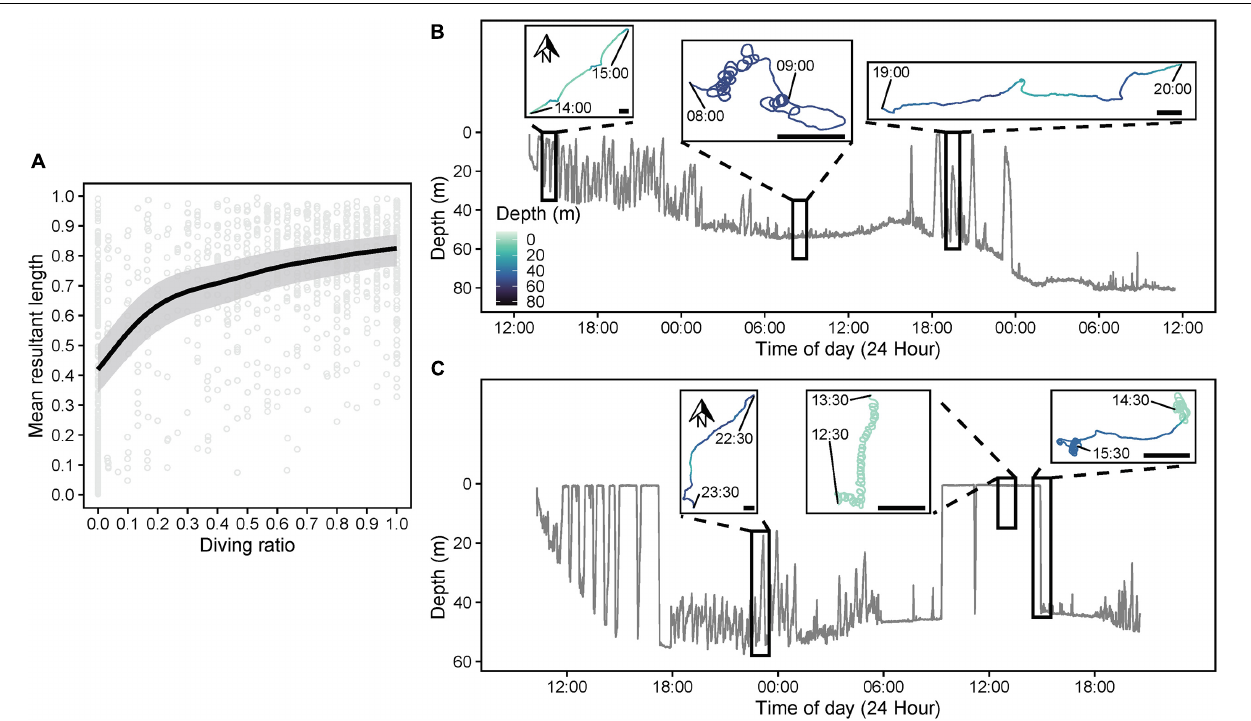
FIGURE 9 | (A) Predicted relationship (gray shading = 95% confidence intervals) between diving ratio (DR, proportion of time spent diving/in states 1 or 2) and mean resultant length ( R , 1 = low heading variance, 0 = high heading variance) from a beta generalized additive mixed model. DR and R were computed over 15 min windows for each shark. Dive profiles and corresponding pseudo-track sections over relevant windowed periods (black rectangles) for sharks (B) s291w and (C) s330w indicating representative examples of linear swimming during intensive diving periods and tortuous activity, including circling behavior, during level phases at the seabed and the surface. The depth color scale is consistent among all plots. For pseudo-tracks, x- (pseudo-longitude) and Y -axes (pseudo-latitude) are scaled equally, and north is toward the top of each plot. A 200 m scale bar is also indicated on each pseudo-track to indicate the approximate relative spatial scale of movement, assuming a fixed swimming speed (0.82 m s − 1 ) for all